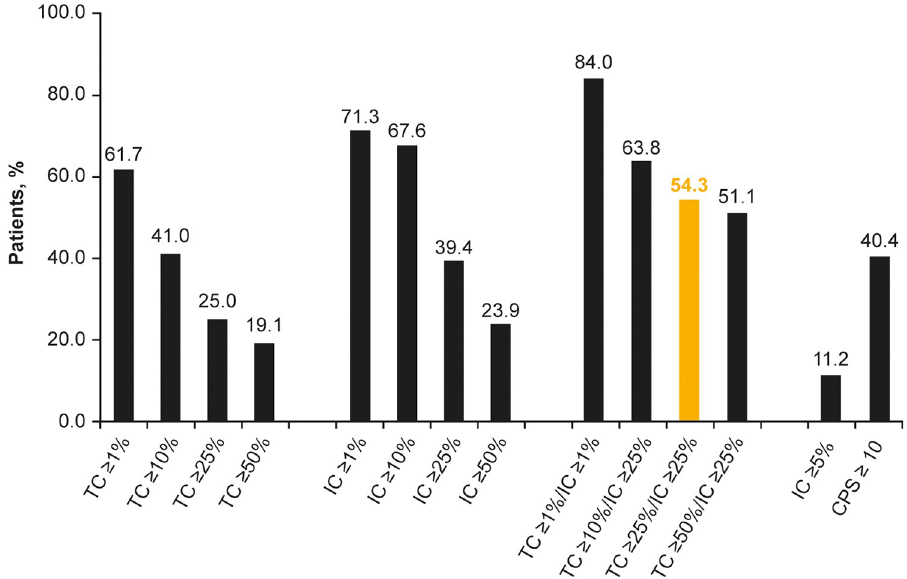
Fig 1. Prevalence of PD-L1–high patients at different TC and IC cutoffs for defining positive PD-L1 expression in study 1108. IC, tumor-infiltrating immune cells; PD-L1, programmed death ligand-1; TC, tumor cells. Highlighted bar indicates the PD-L1 cutoff previously used to investigate response to